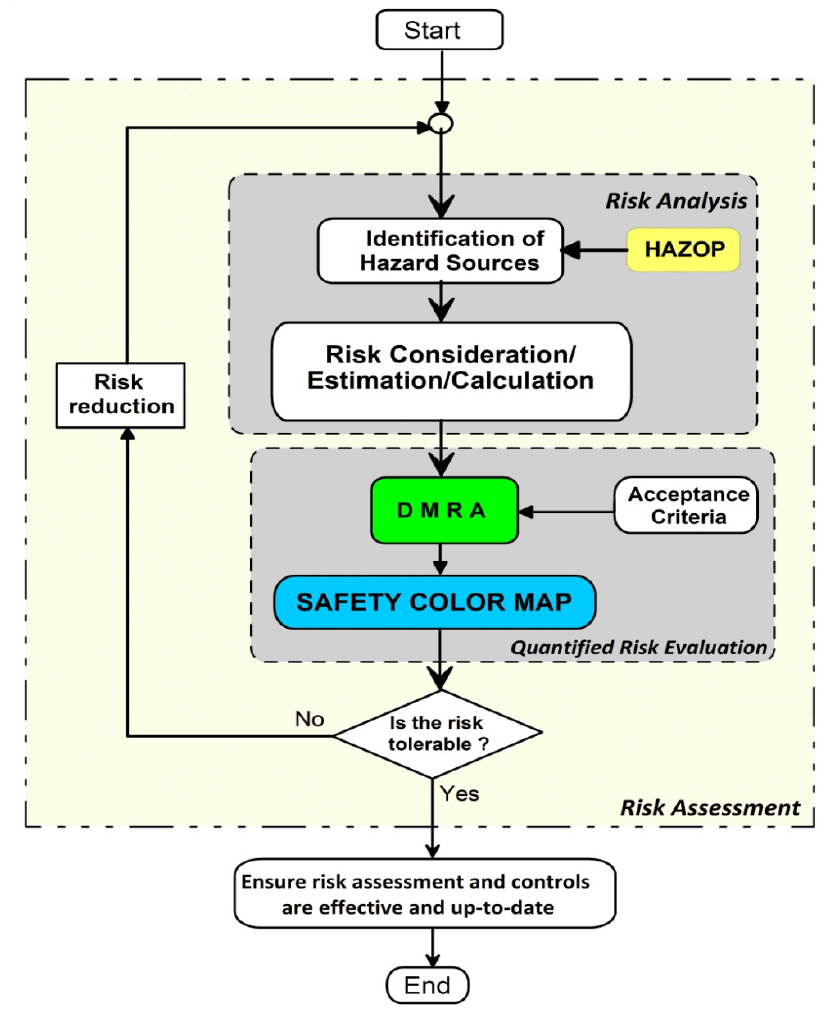
Figure 5. The flow-chart of the suggested HAZOP-DMRA RAA framework, which in addition incorporates the process of creating SCMs, as a segment of the risk management procedure.